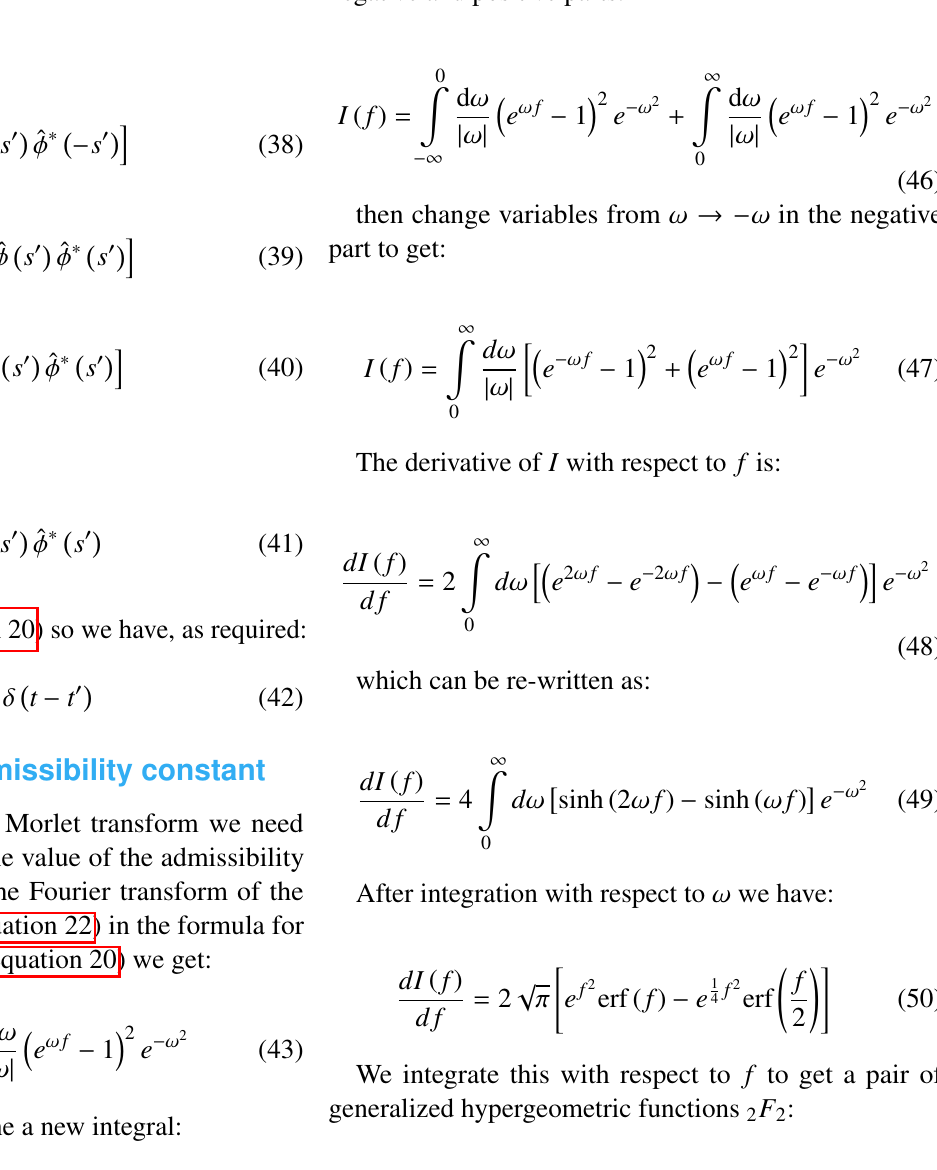
Figure 2: The admissibility constant C f as a function of